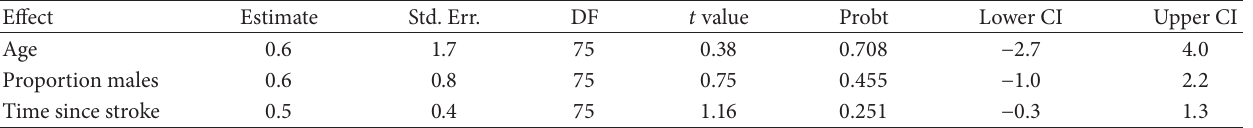
Table 3: Meta-regression coefficients for all studies.